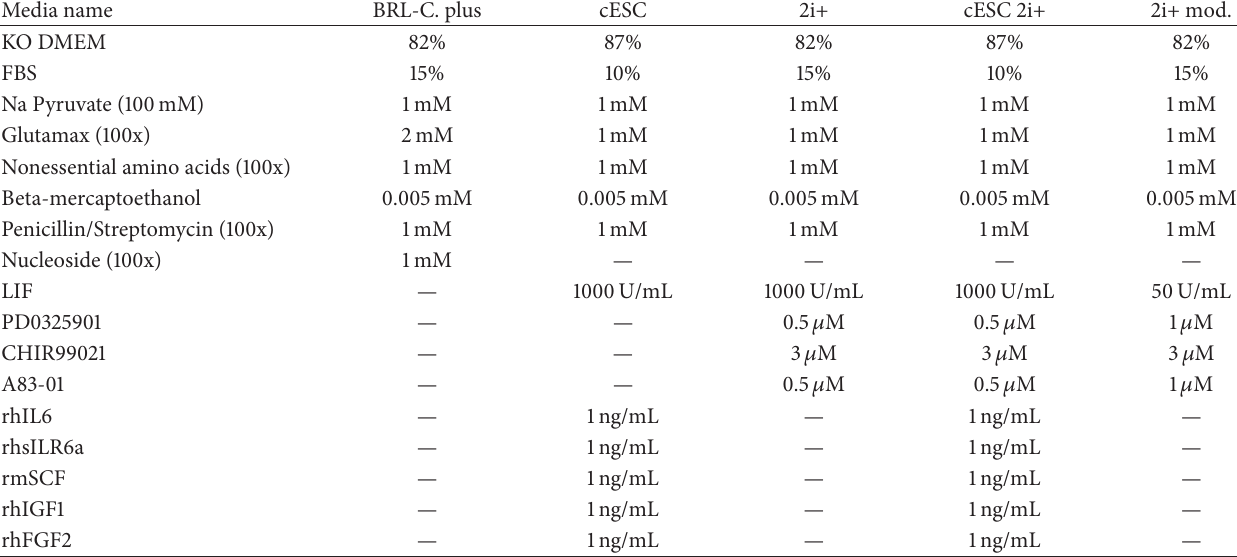
Table 1: Ingredients of the five passaging media conditions presented in this